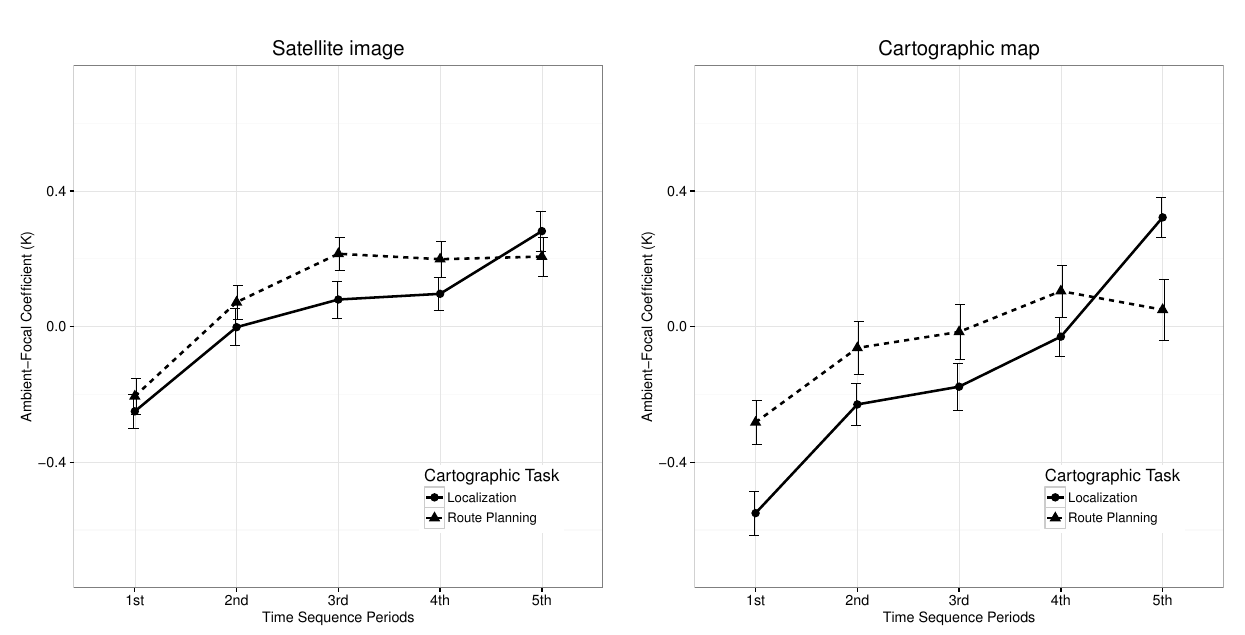
Figure 5 . Dynamics of coe ffi cient K representing ambient / focal attention. The interaction e ff ects of task and time sequence for satellite and cartographic maps. Whiskers represent ± 1SE (standard